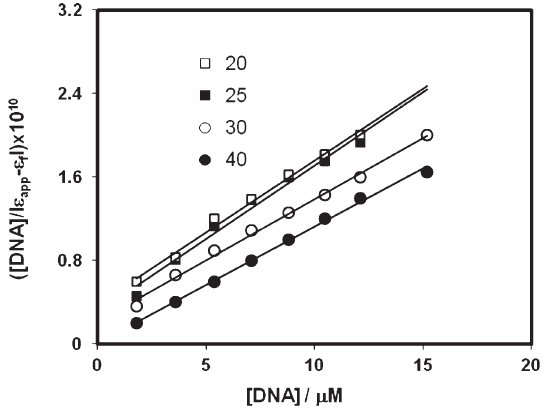
Fig. 4. Typical plots of [ poly ( G − C )] total [ poly ( G − C )] total for the determination of the equilibrium bind- ing constant ( K app ) based on Eqn. (1) of the poly ( G − C ) binding of Zn (tmtppa) at various temperatures.